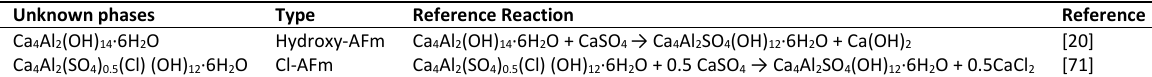
Table 2. Reference reactions used to calculate heat capacity based on structurally similar phases. Unknown